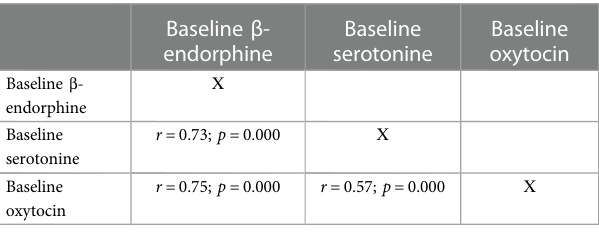
TABLE 5 Correlation matrix of β -endorphin, serotonin, and oxytocin levels after SSC. β -endorphine after SSC Serotonine after SSC Oxytocin after